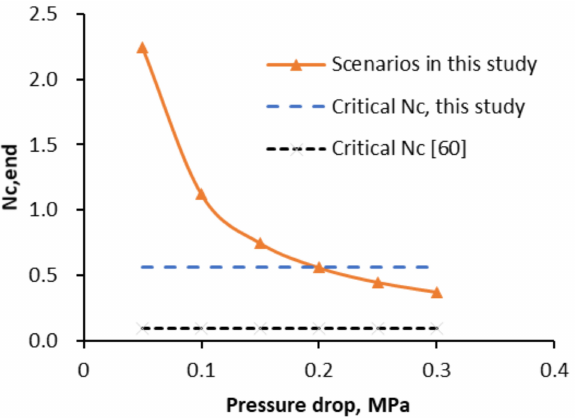
Figure 10. End-effect number for different pressure drop scenarios.